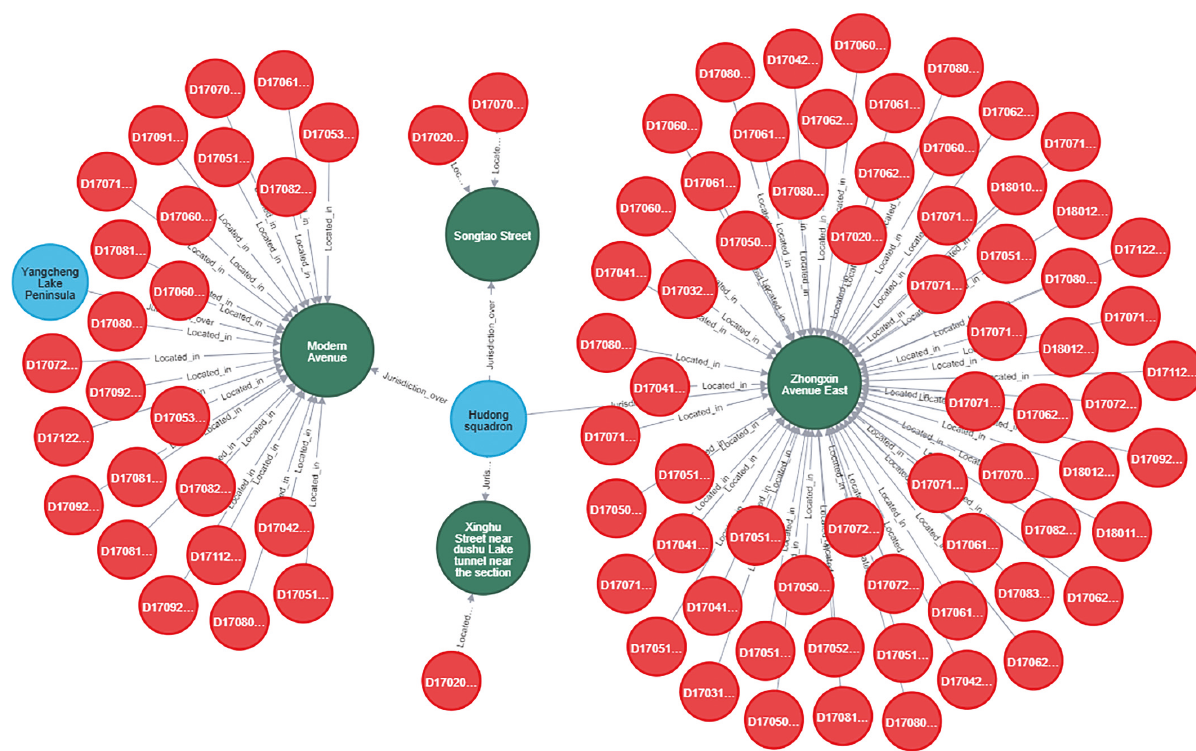
Figure 13: Visual display of accident association